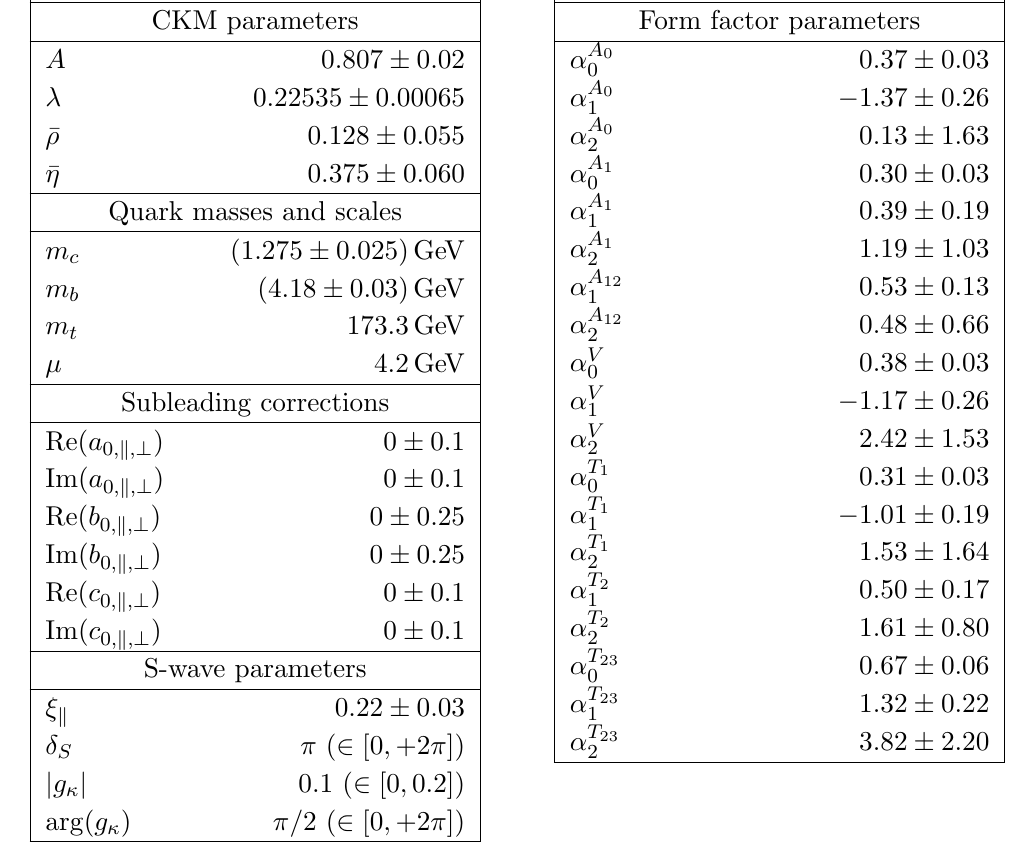
Table 2. Nuisance parameters from theory used in the pseudoexperiments. The given uncertainties indicate the Gaussian constraints used in the (cid:12)t. The form factor parameters are constrained in the (cid:12)t using the full covariance matrix reported in ref.